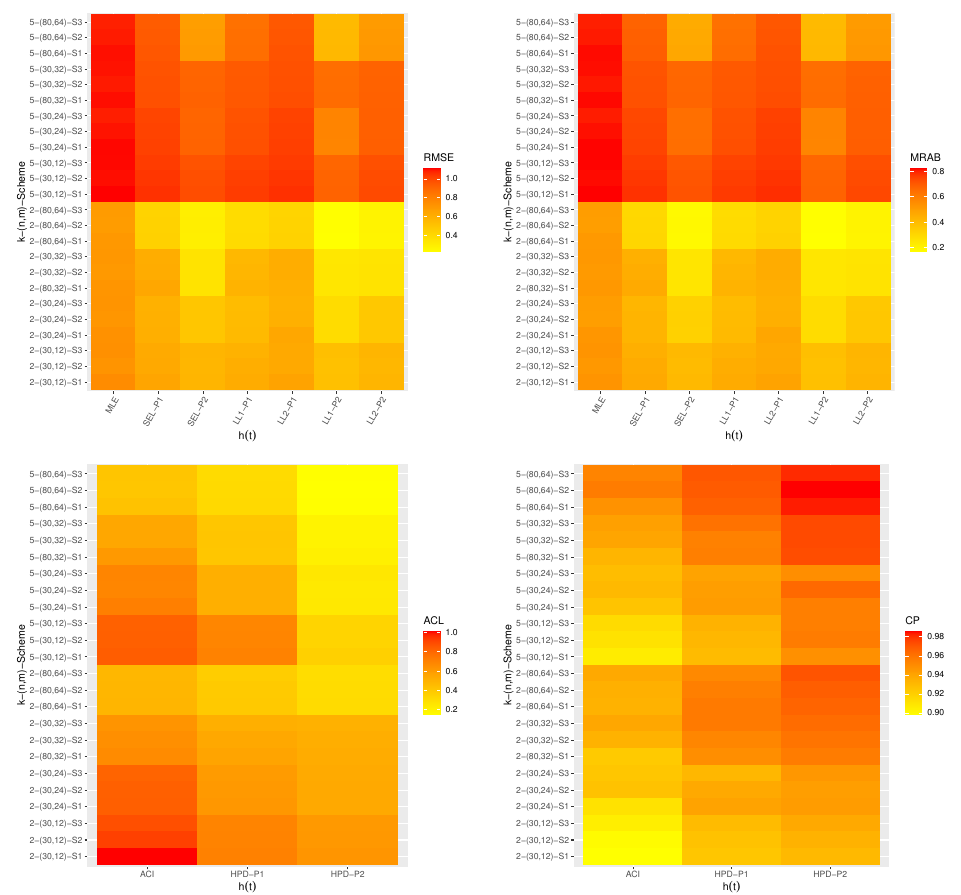
Figure 4. Heatmap plots for classical and Bayesian estimation results of h ( t ) .